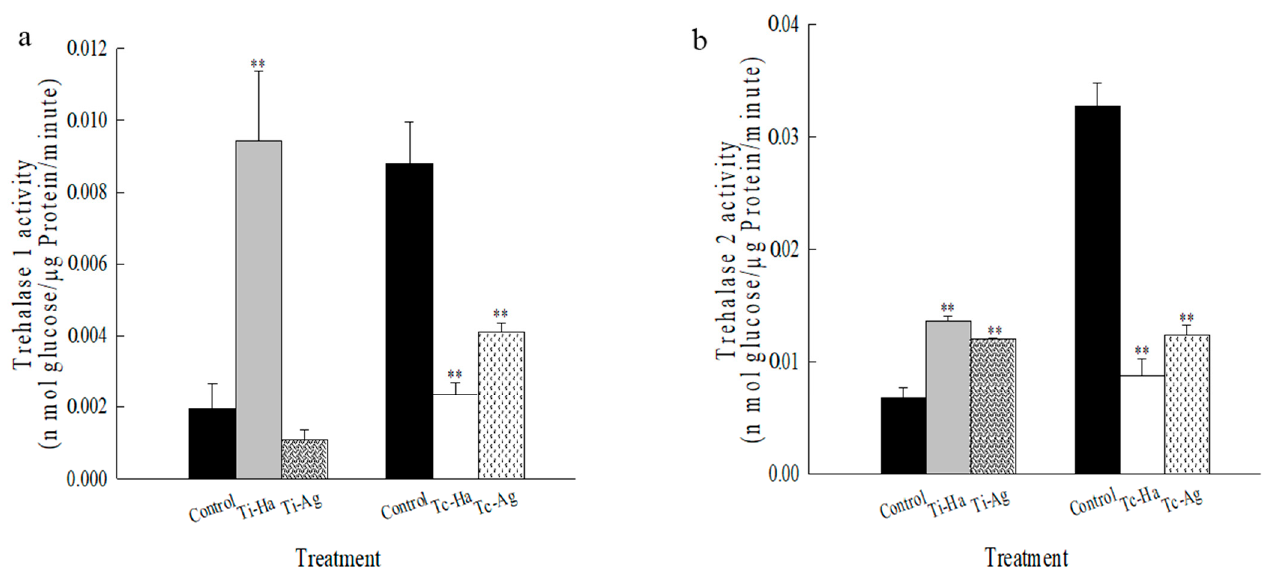
Figure 4. ( a ) TRE1 (trehalase 1) enzyme activity changes under imidacloprid and chlorpyrifos treatment. ( b ) TRE2 (trehalase 2) enzyme activity changes when treated with imidacloprid and chlorpyrifos. ** on the column respectively extremely significant differences from the control group at 0.01 (one-way ANOVA).